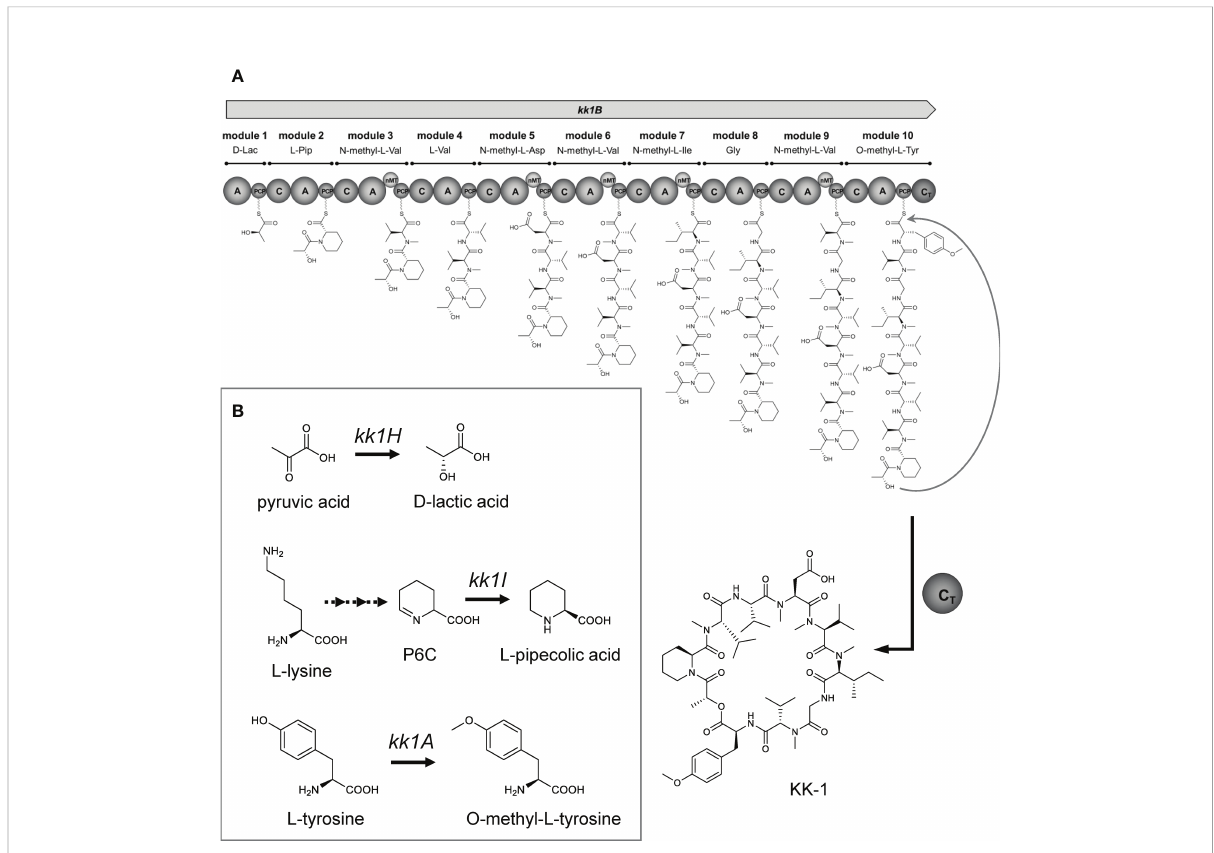
FIGURE 11 The proposed biosynthetic pathway for KK-1. (A) The proposed model for the KK-1 non-ribosomal peptide synthetase assembly line: C, condensation domain; A, adenylation domain; PCP, peptidyl carrier protein domain; nMT, nitrogen methyl transferase; CT, condensation-like domain. (B) The proposed pathway for the biosynthesis of non-amino acids or non-proteinogenic amino acids building